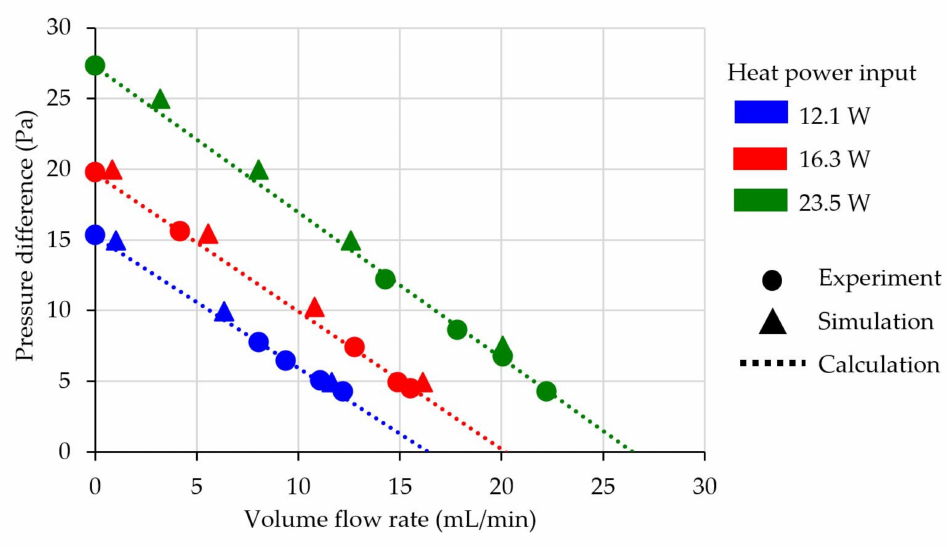
Figure 8. Thermal transpiration membrane performance at different heat power